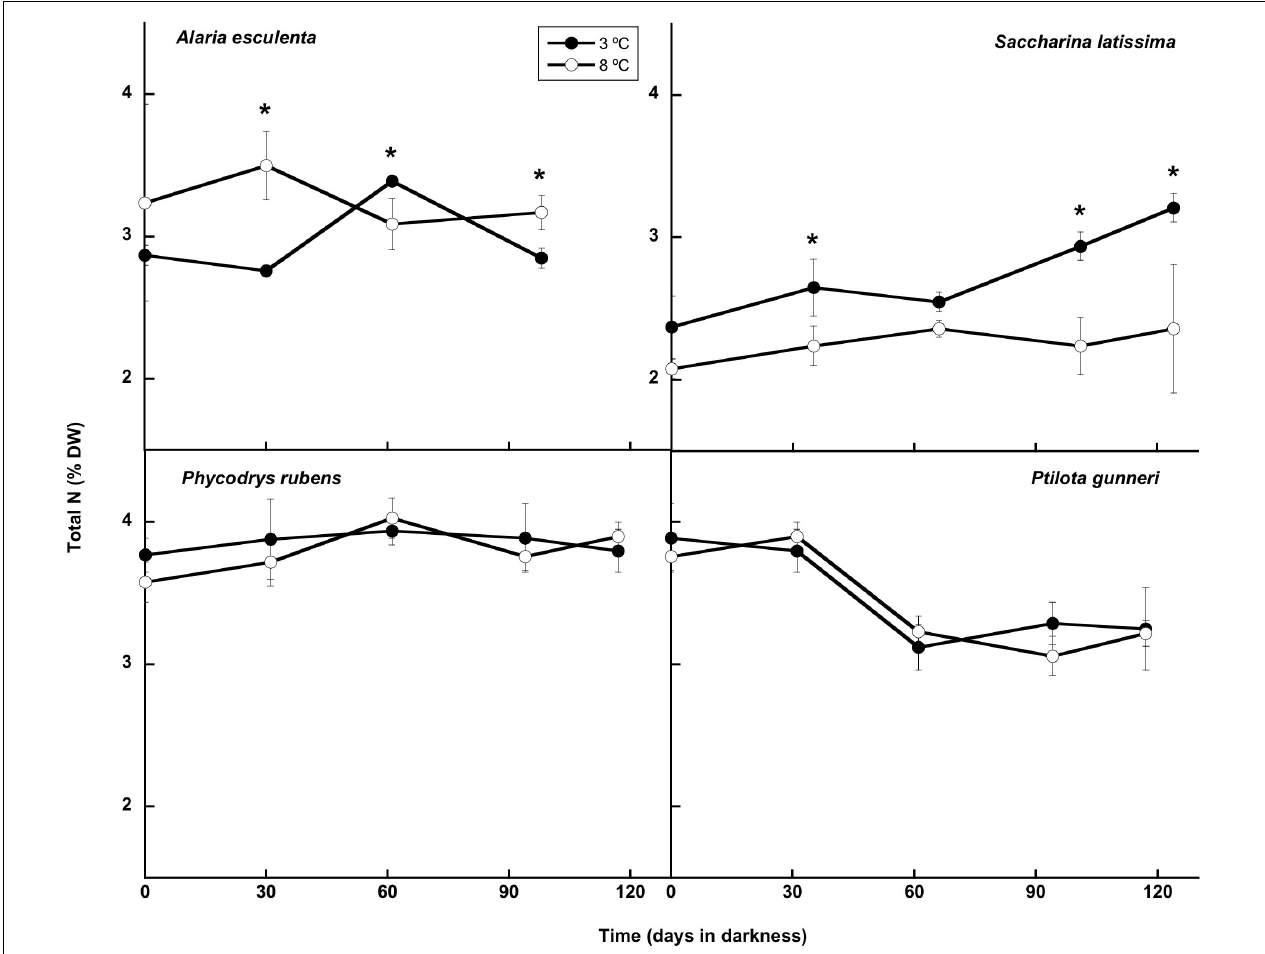
FIGURE 8 | Total N during the 16 weeks of incubation in darkness of Alaria esculenta , Saccharina latissima , Phycodrys rubens , and Ptilota gunneri at two different temperatures. Data are mean of 5 replicates (error bars for standard deviation). Significant differences between temperatures marked with an